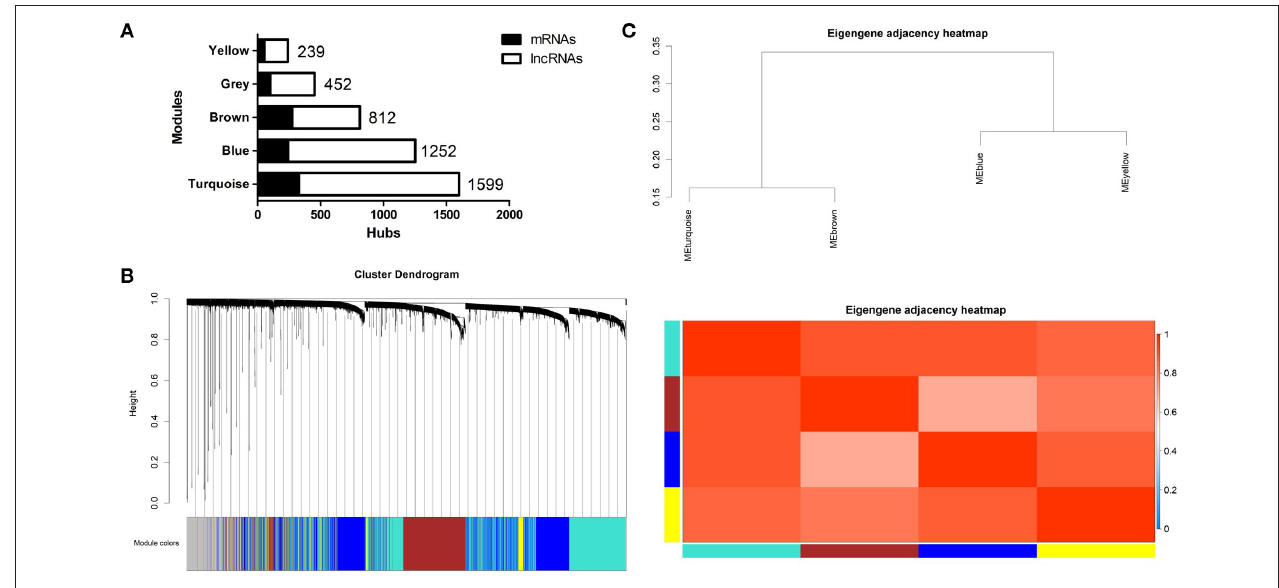
FIGURE 4 | (A) Size and composition of the modules in the WGCNA network. (B) Dendrogram obtained by clustering the dissimilarity based on consensus topological overlap with the corresponding module colors indicated by the color row. (C) Eigengene adjacencies of heatmap. Red shows high